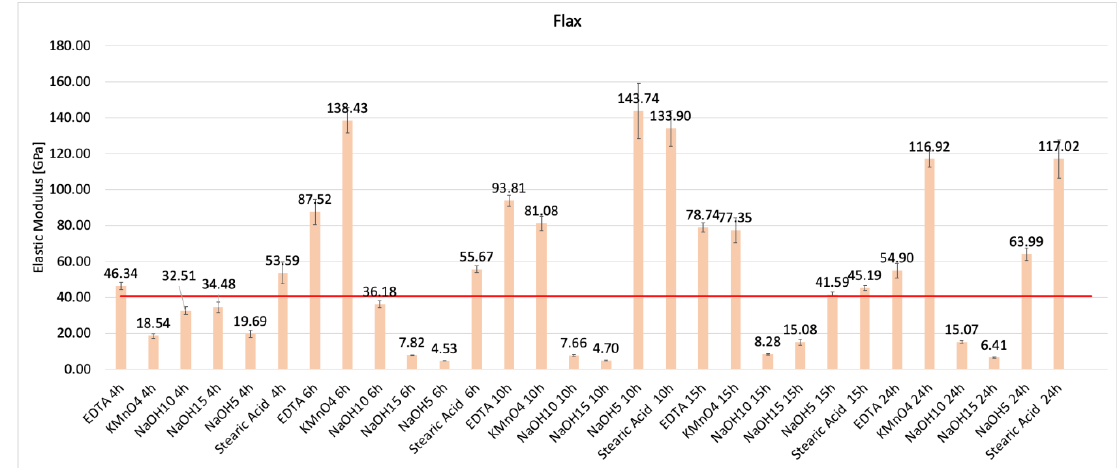
Figure 9. Elastic modulus obtained for each treatment on flax fibres.